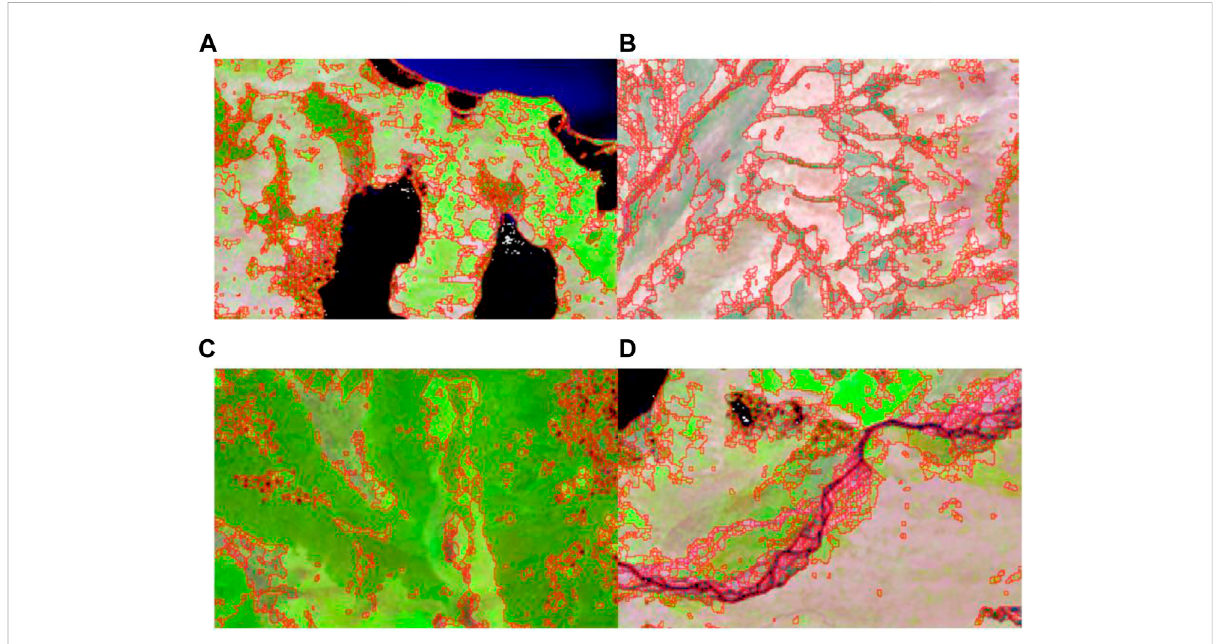
Image segmentation sketch diagrams of representative areas based on Landsat eight OLI. The red line represents the object border. (A) Marsh, high coverage vegetation areas, low coverage vegetation areas, and lakes; (B) fl ooded wetlands, bare land, and low coverage vegetation areas; (C) high coverage vegetation areas, low coverage vegetation areas and marsh; (D) Rivers, fl ooded wetlands, marsh, and low cover vegetation areas.